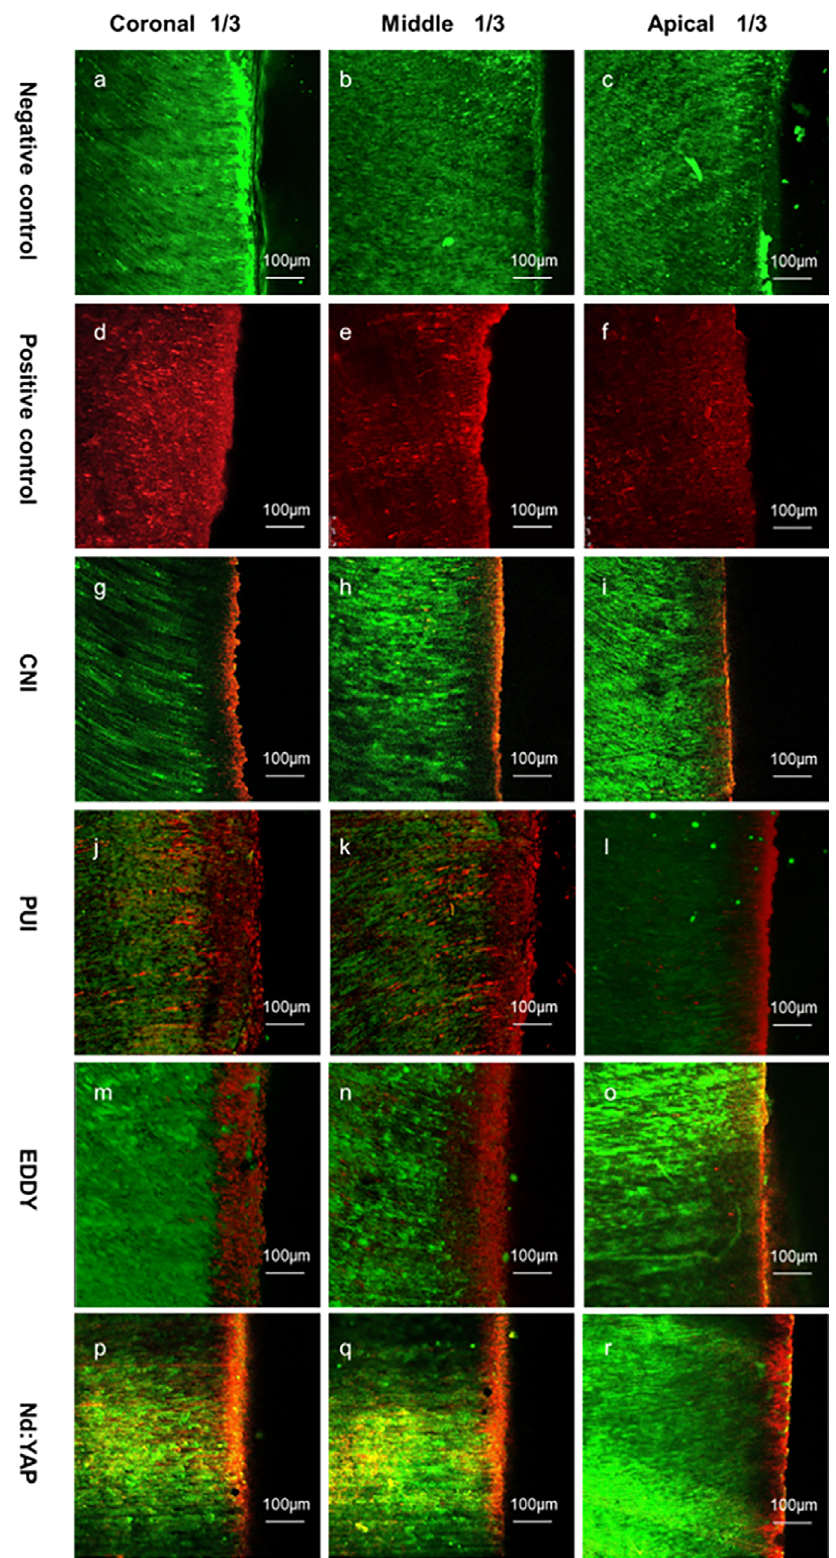
Figure 2- Distributions of live and dead bacteria in dentinal tubules. The black area is the root canal and the fluorescent area is dentin. The interface is the surface of the root canal wall; green fluorescence represents live bacteria and red fluorescence represents dead